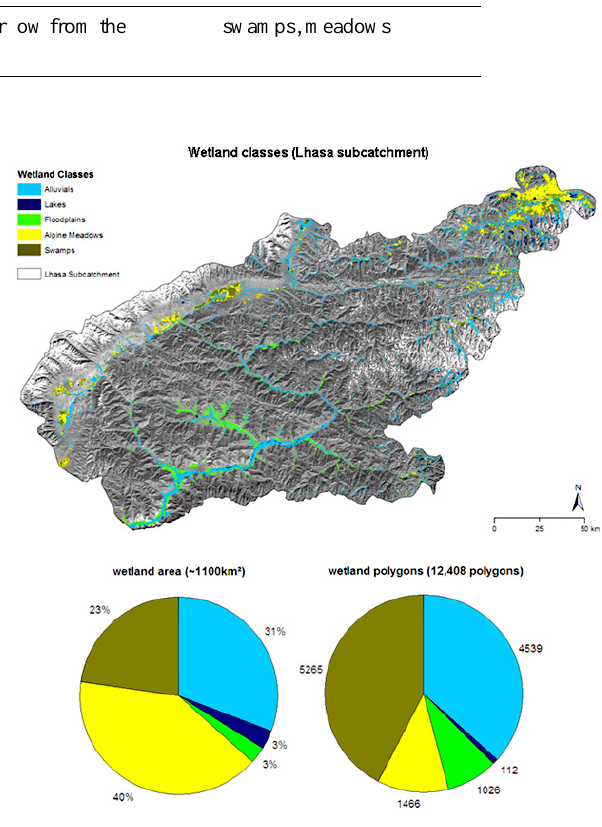
Figure 10. Lhasa sub-catchment: Wetland classes (top); Wetland area (left) and polygons